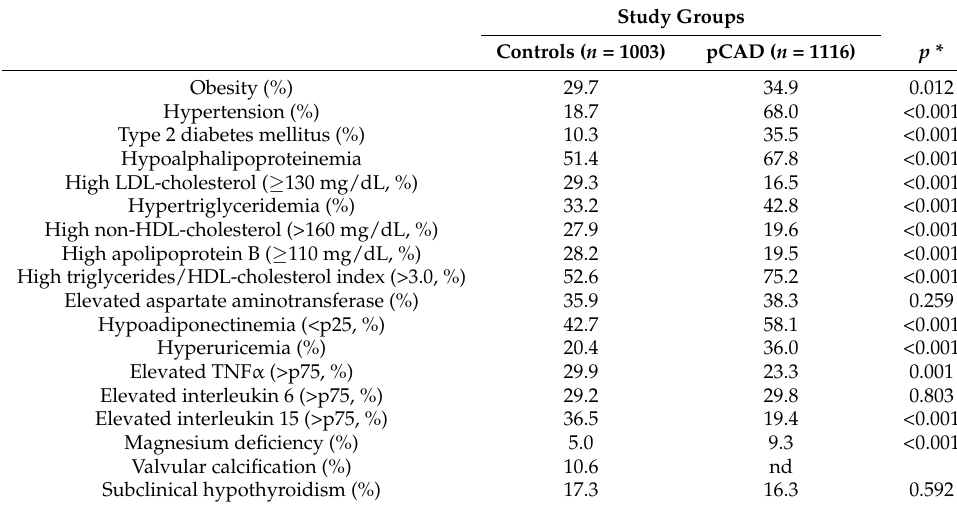
Table 2. Prevalence of coronary risk factors in the study